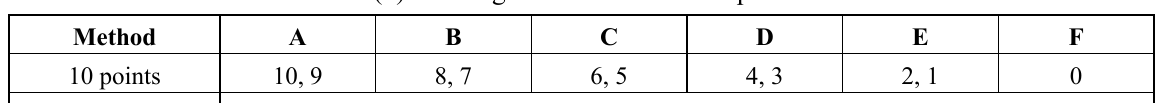
Table 2. The ranking tables of environmental impact, healthy harm and noise. ( a ) Ranking of environmental